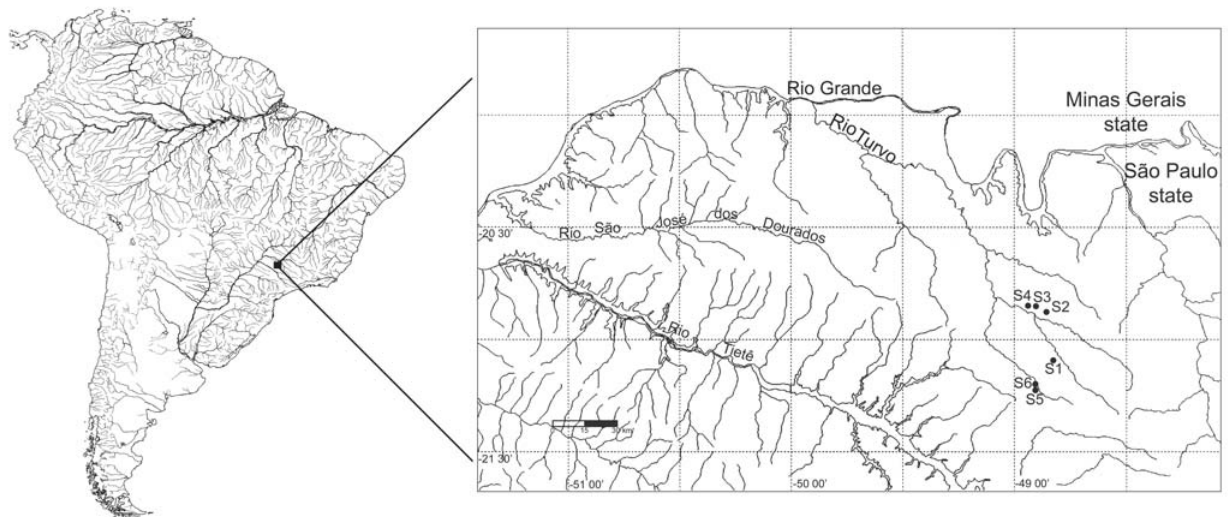
Fig. 1. Location of the sampling sites in the upper rio Paraná basin, southeast